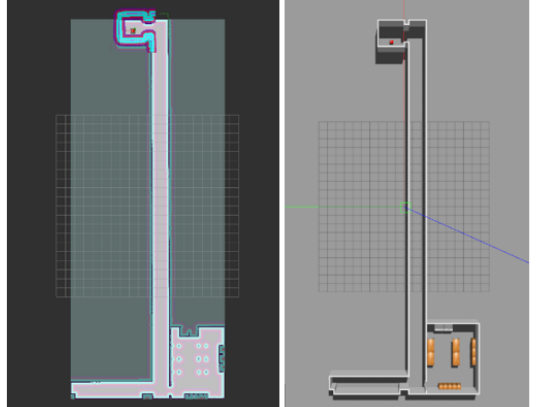
Figure 26. Navigation results of simulation scene.